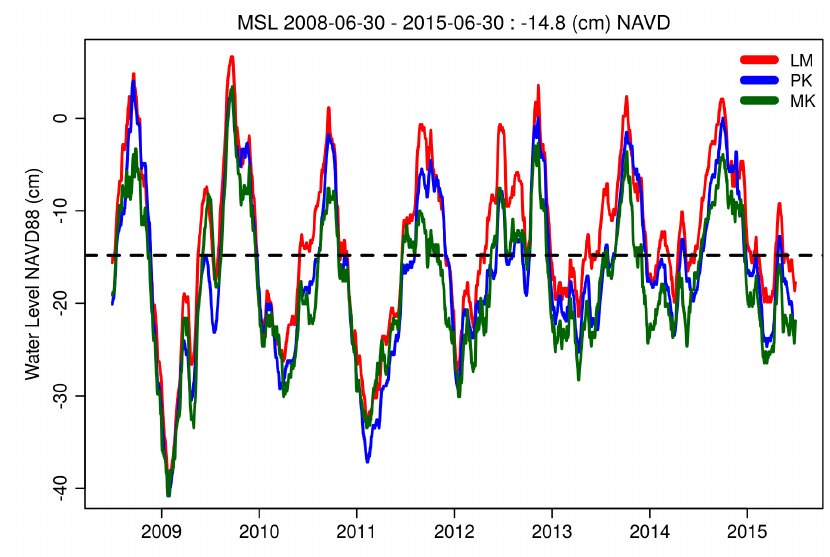
Figure A1. Thirty-day moving averages of daily mean sea level at Murray Key (MK), Peterson Key (PK) and Little Madeira Bay (LM) in Florida Bay. The dashed line is the mean of all three